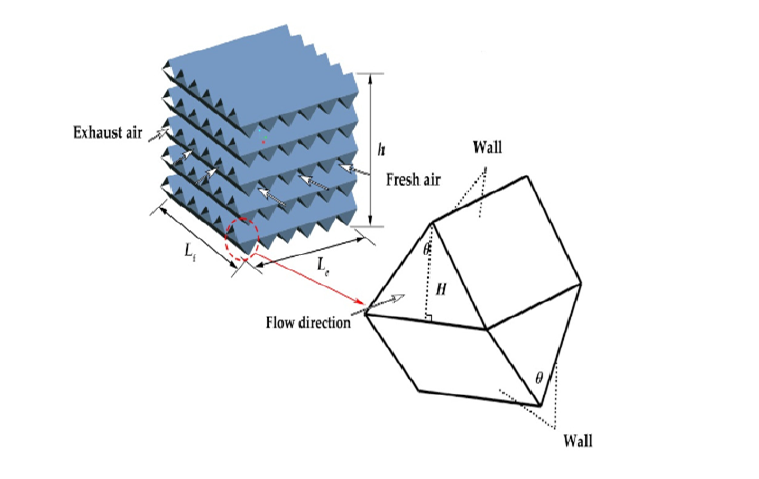
Figure 11. Chosen geometry for the heat exchanger